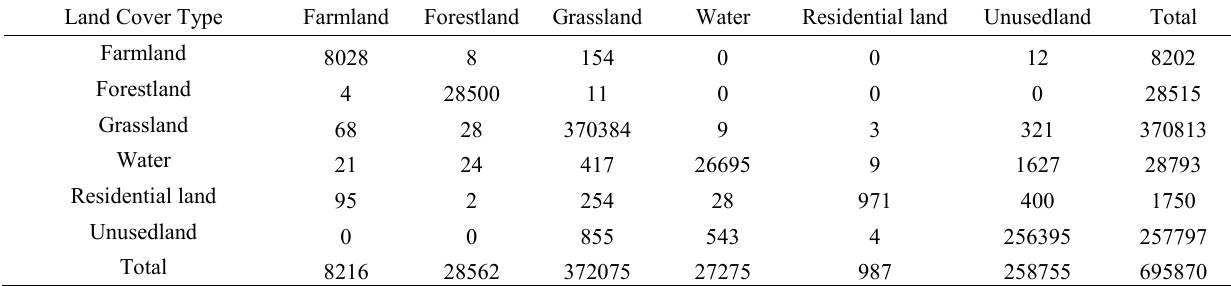
Tab.3 Land Use Change Matrice for the period of 2000-2015 （ km 2 ）